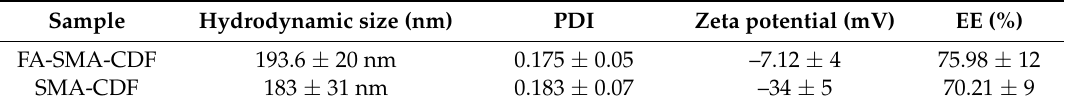
Figure 3. ( a ) Particle size characterization of SMA-CDF and FA-SMA-CDF using the dynamic light scattering (DLS) technique; ( b ) surface morphology of SMA-CDF and FA-SMA-CDF by transmission electron microscopy (TEM); ( c ) differential scanning calorimetry (DSC) of pure drug (CDF), FA-SMA, and FA-SMA-CDF nanoformulations. Table 1. Characterization of FA-SMA-CDF micelles. EE, encapsulation efficiency.